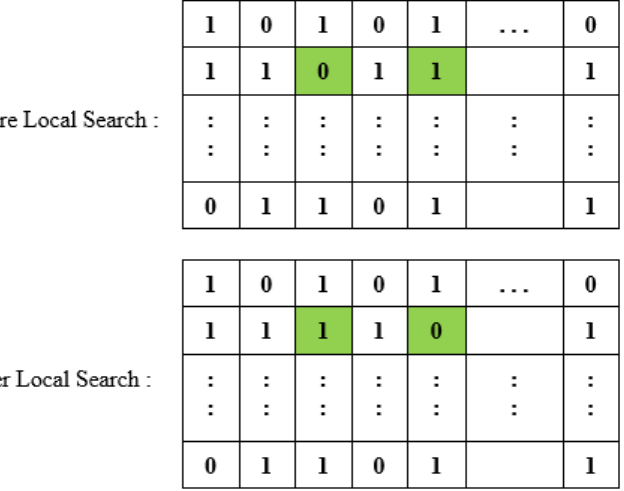
Fig. 12. Binary exchange local search operator for binary structure Sjt.